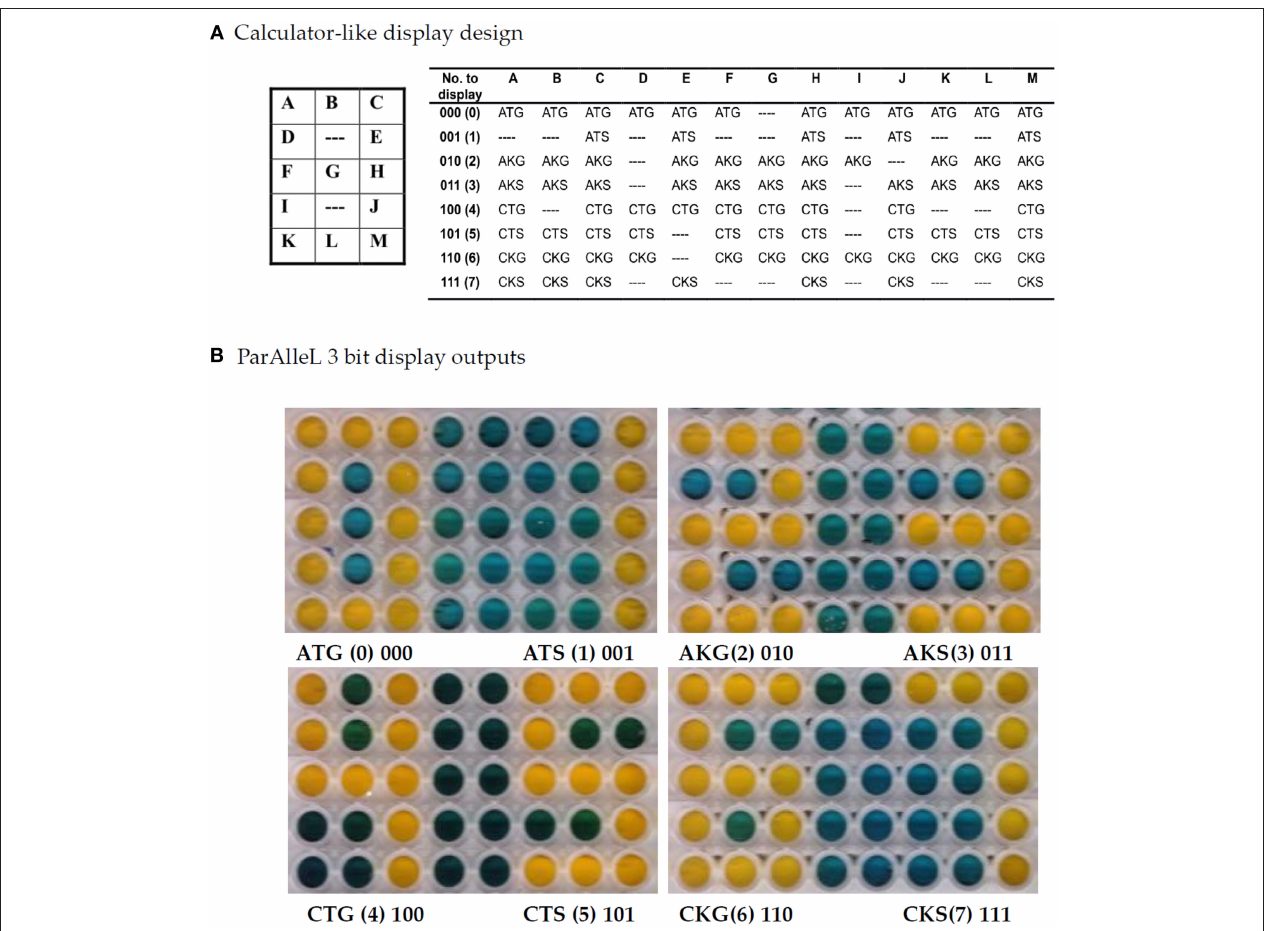
FIGURE 2 | Digital calculator-like display using 3 bit ParAlleL. Figure shows all numerals from zero to seven based on the 8 binary inputs provided. (A) Subcircuit cells were mixed and distributed in a 3 × 5 matrix and inoculated (1:100) in LB supplemented with 1%w/v glucose. Plate was developed after 18h of incubation, by addition of 0.05 volumes of developing solution. (B) Output number results obtained by addition of each 3 bit antibiotic combination.